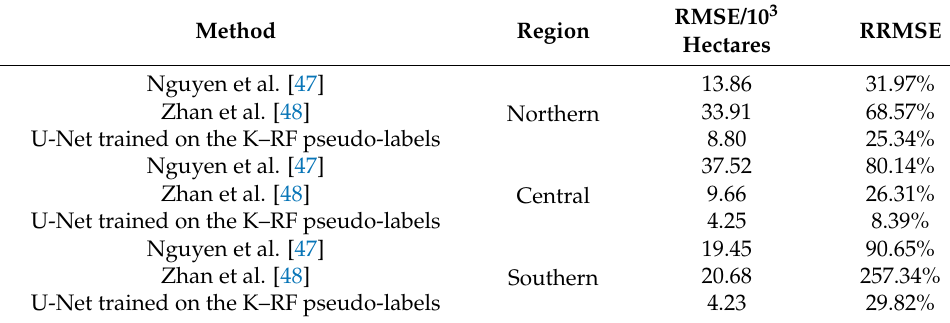
Table 4. The comparison with rule-based rice mapping